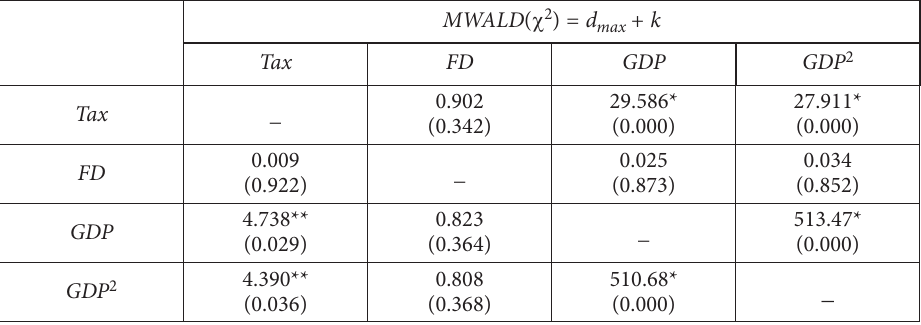
Table 9. Toda-Yamamoto Granger causality results with GDP squared